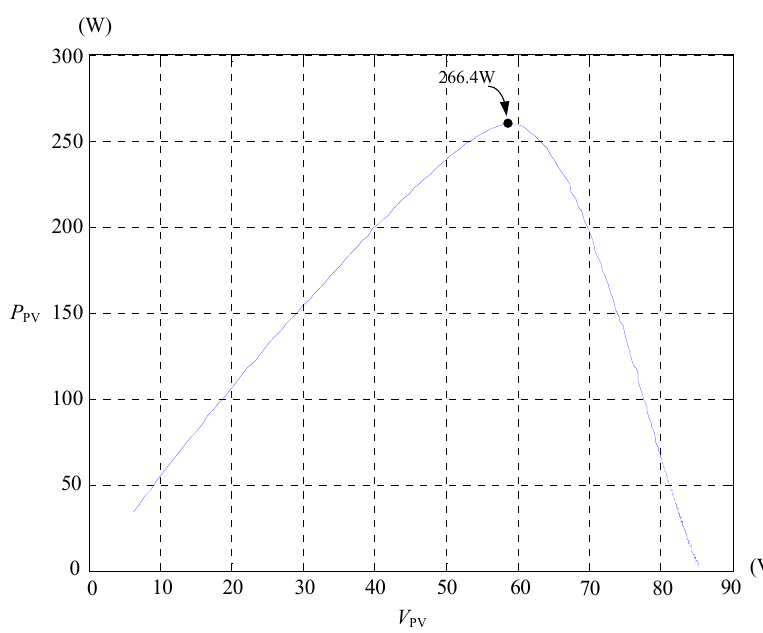
Figure 7. A single experimental P–V characteristic curve for all optimized configurations in Case 3. 5.1.4. Case 4: A 30% Shaded PV Module in Row 4 (Module 4, 8, or 12) The same test as in Cases 1–3 is repeated on the case of a single 30% shaded module on the fourth row. The optimized array configurations are presented in Table 2, but not illustrated for brevity. The highlighted portions in purple indicate that the output power is optimized on a condition that switches S 3 and S 8 are switched on. The same P–V characteristic curve as in Figure 5 is seen again in Figure 8 for this case. The peak power plunges from 334 W in an unshaded case to 265.6 W in this case.